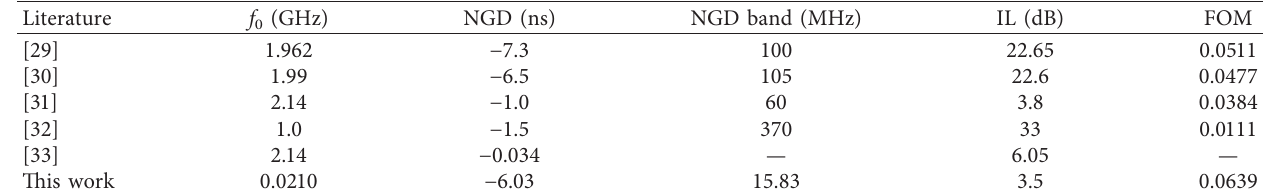
Figure 22: S parameters of the band-pass negative group delay of the band-stop Table 10: Performance comparison between band-pass negative group delay in the passband of the band-stop filter and the proposed NGD band-stop filter.